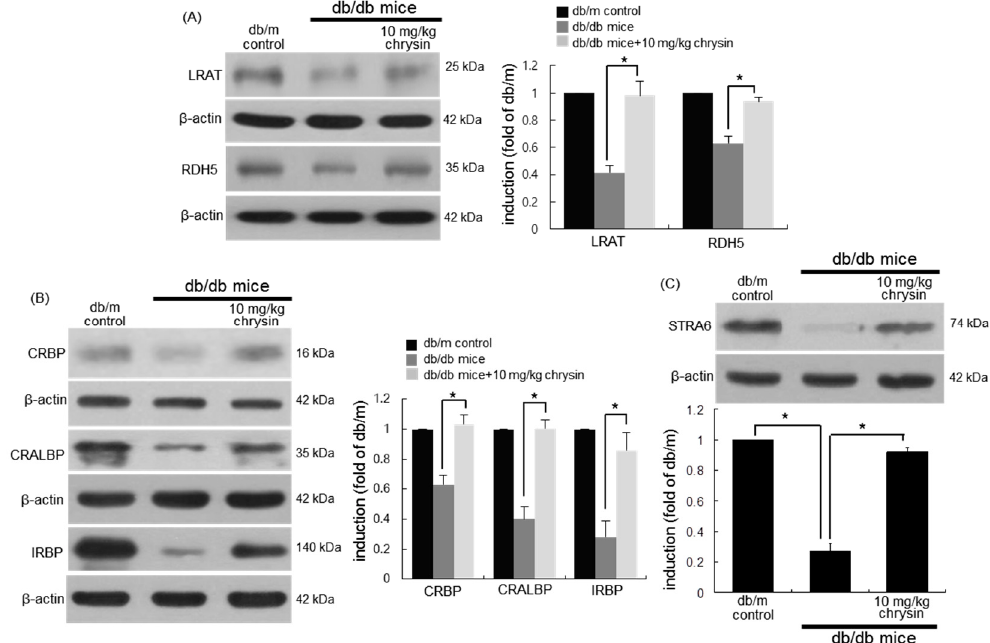
Figure 4. Elevation of retinal tissue induction of visual cycle enzymes ( A ), and retinoid binding proteins ( B ), and stimulated by retinoic acid 6 (STRA6, C ) in chrysin-treated mice. The db/db mice were orally supplemented with 10 mg/kg of chrysin daily for 10 weeks. The db/m mice were introduced as control animals. Mouse retinal tissue extracts were subject to Western blot analysis with a primary antibody against each target protein of lecithin-retinol acyltransferase (LRAT), retinol dehydrogenase 5 (RDH5), cellular retinol binding protein (CRBP), cellular retinaldehyde-binding protein (CRALBP), interphotoreceptor retinoid-binding protein (IRBP), or STRA6. β -actin protein was used as an internal control. Bar graphs (mean ± SEM, n = nine independent experiments) in the bottom or right panels represent densitometric results of upper blot bands. * Values in bar graphs indicate a significant difference at p < 0.05.